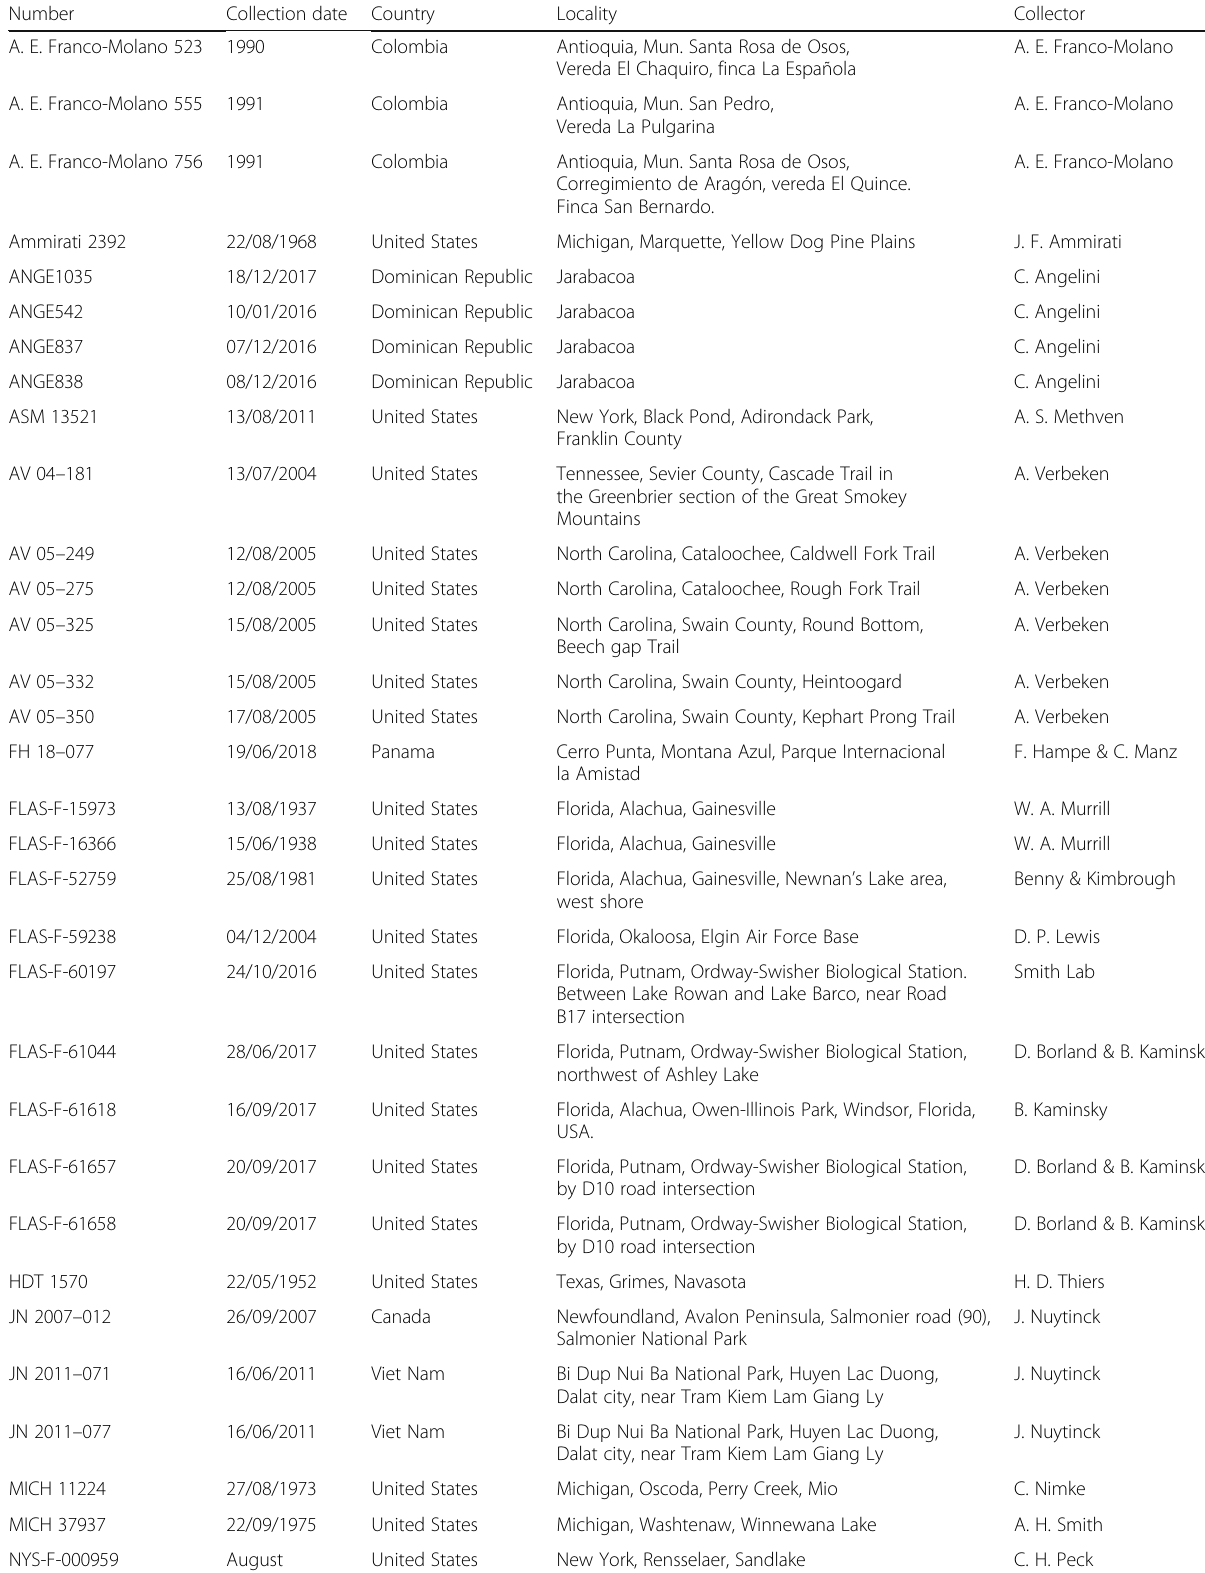
Table 2 Metadata of collections in the L. deceptivus complex